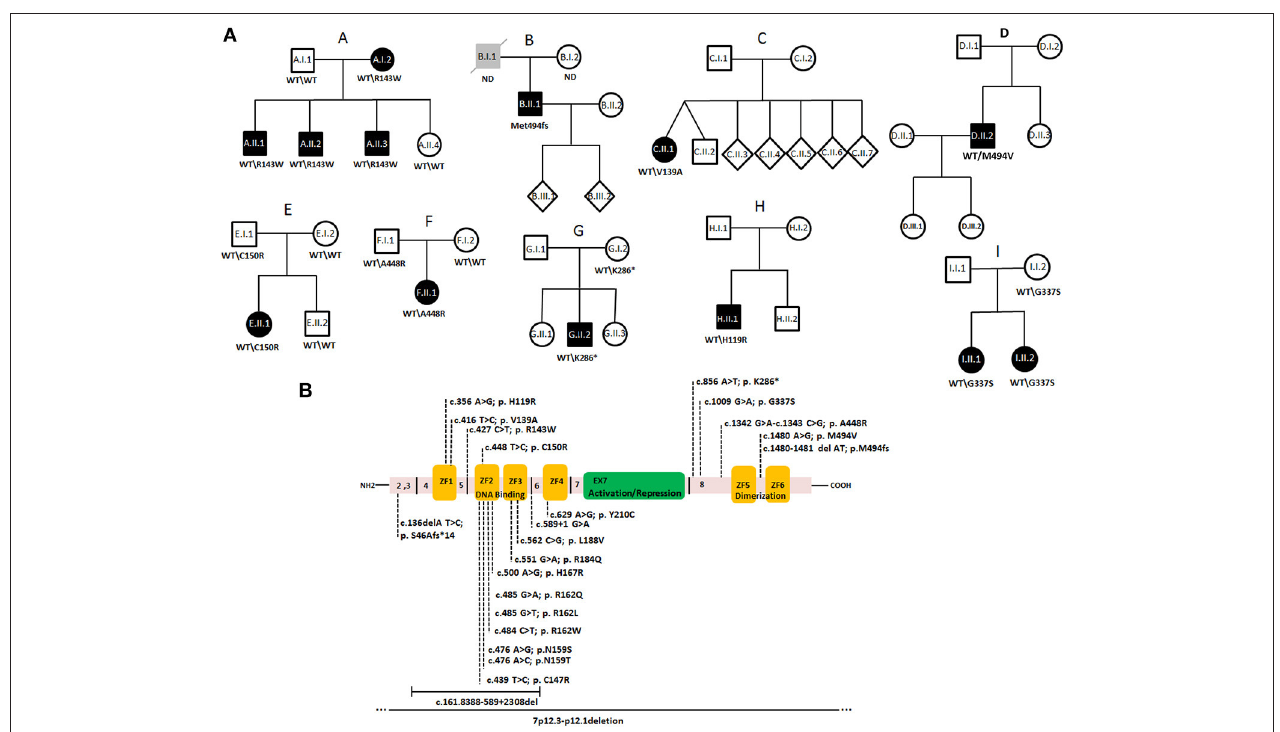
FIGURE 1 | Autosomal dominant inheritance of IKAROS heterozygous mutations in CVID families of a cohort of 650 individuals. (A) Pedigrees of families A–I. Circles, female; squares, male; black filled symbols, affected individual; gray filled symbols; individual with hypogammaglobulinemia without CVID-related symptoms, open symbol; unaffected; slash, diseased. (B) Schematic presentation of the structure of human IKAROS. The N-terminal DNA binding domain composed of four zinc finger motifs (yellow boxes, ZF1–ZF4), the central activation/repression domain (green) and the C-terminal dimerization domain (ZF5–ZF6). Exon borders and amino acid positions are indicated. Dotted lines in the upper part indicate heterozygous variants identified in this study. Lower parts shows previously published IKZF1 mutations ( 16, 34–38).